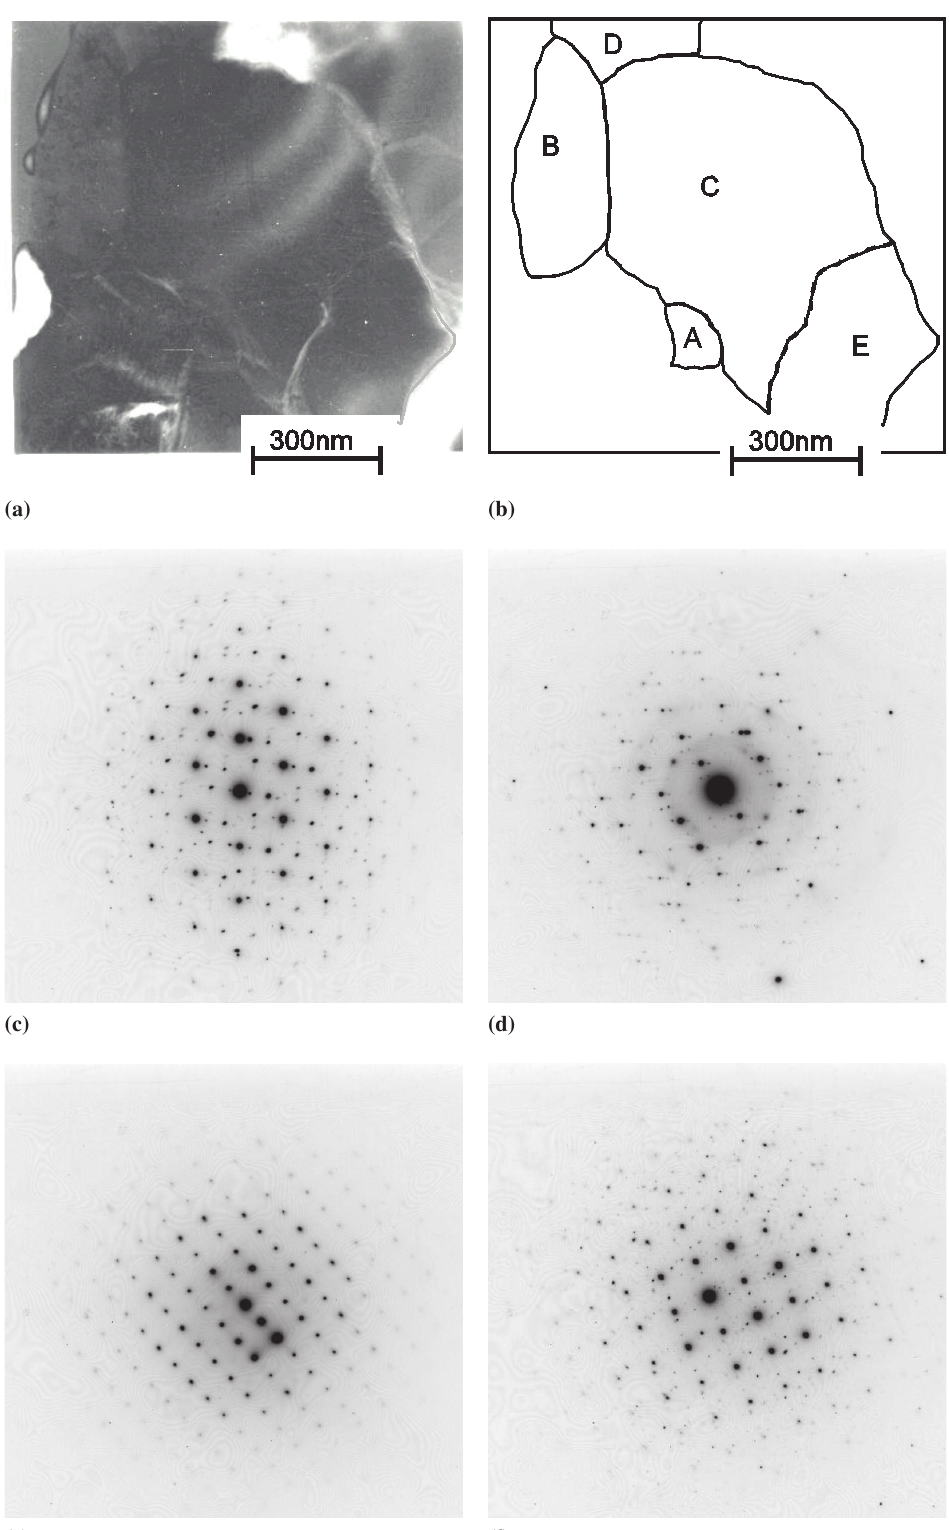
Figure 8. The TEM observation result of a 30 µm particle obtained in experiment II (Humid, 95°C, A) at 24 h. The cross section was obtained by cutting the particle with FIB. (a) Dark field image, (b) schematic view, Electron beam diffrac- tion patterns (c) in region A, (d) in region B, (e) in region C, (f) in region